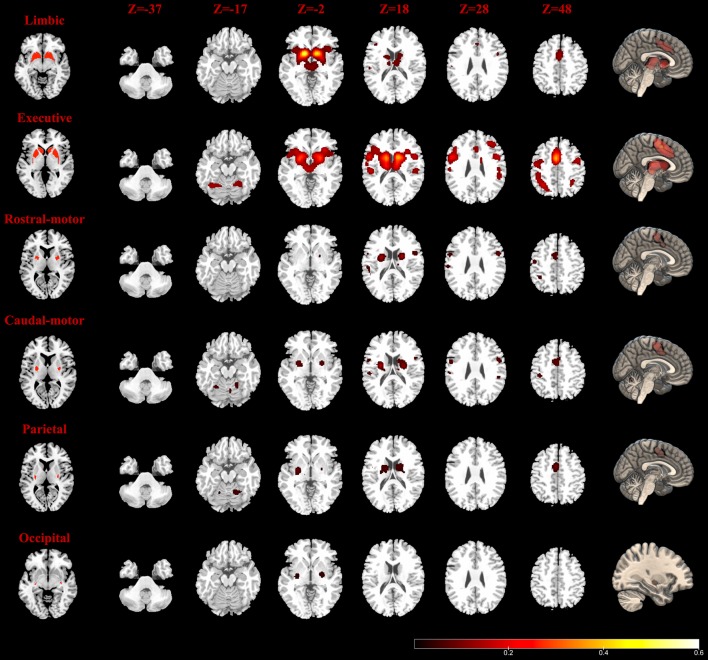
Task-dependent meta-analytic connectivity modeling (MACM) results for the seven striatum subregions. The result of temporal subregion was not demonstrated because of no significant connectivity at the current threshold. The first column (left): six striatum subregions (ROIs); the last column (right): connectivity modeling results of six striatum subregions (FDR correction with a statistical threshold of p < 0.01); middle columns: axial plane views (at z = −37, −17, −2, 18, 28, 48) of connectivity results at the right side.